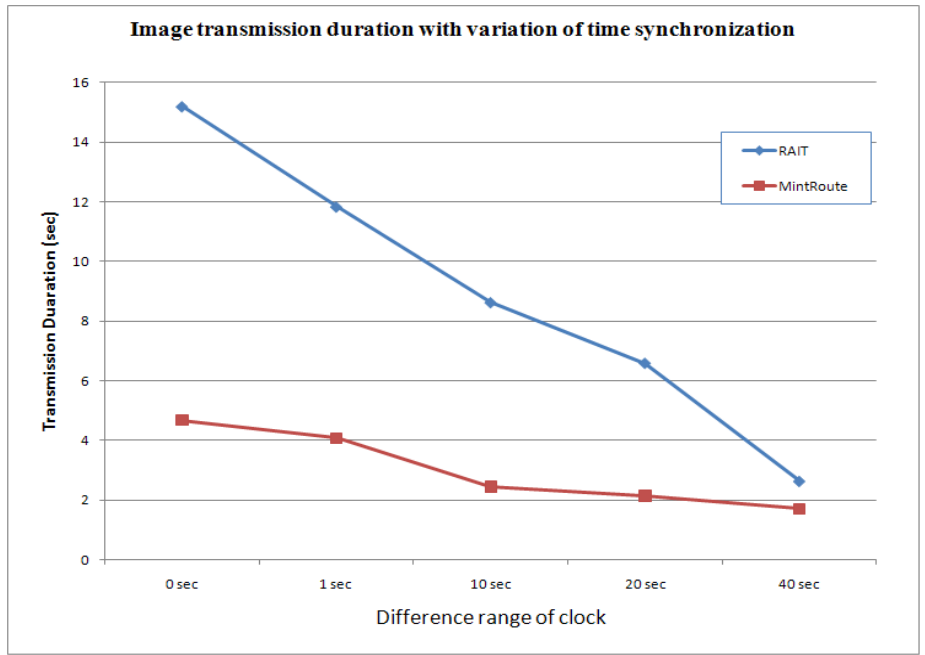
Figure 15. Image transmission duration with variations in time